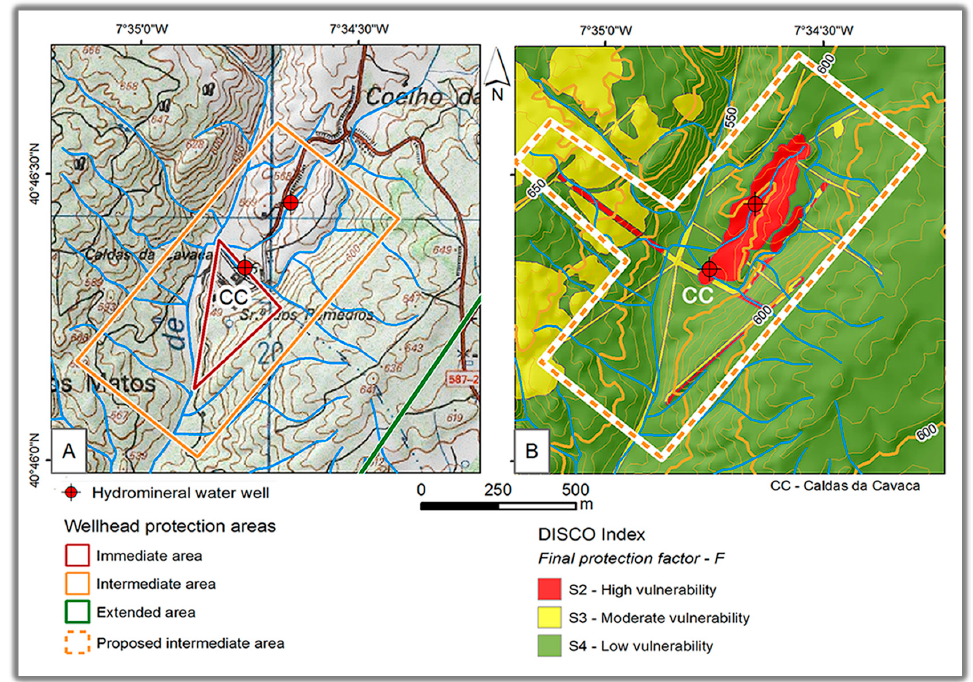
Figure 9. Wellhead protection areas for Caldas da Cavaca hydromineral system: ( A ) wellhead protection areas defined in 1996; ( B ) proposed intermediate wellhead protection area.